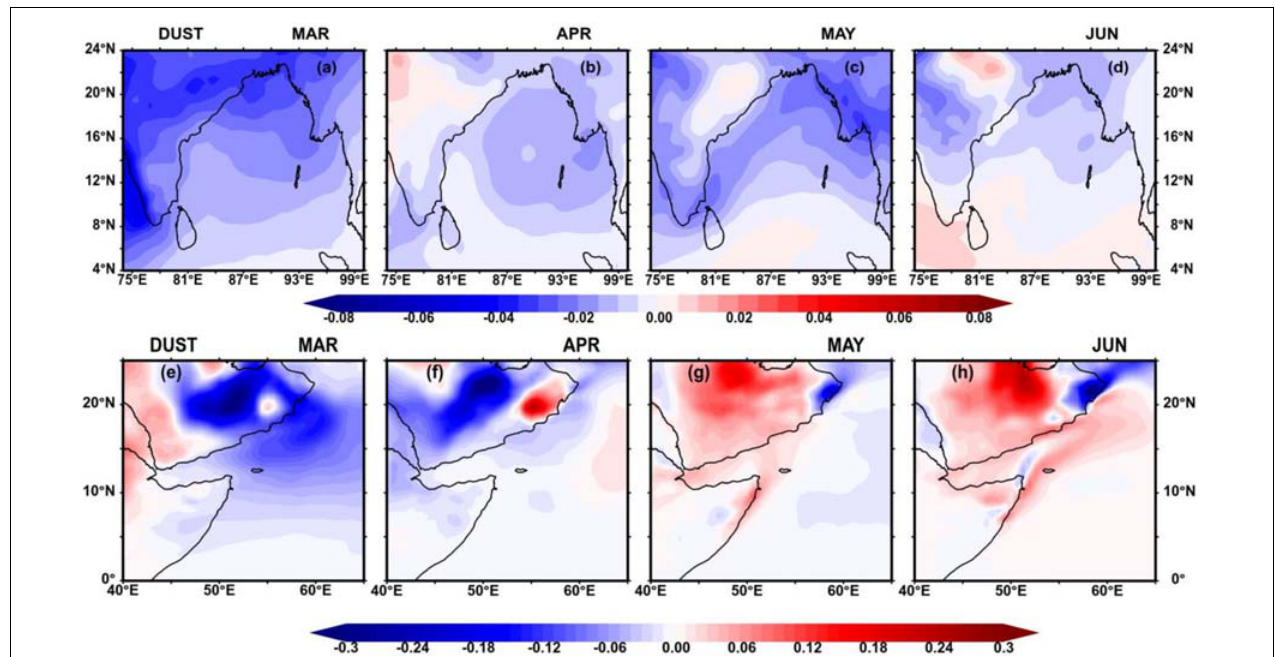
FIGURE 7 | Difference (pandemic – pre-pandemic) in dust mass concentration ( × 10 - 6 kg m - 3 ) over the BoB (A–D) and WAS (E–H) .